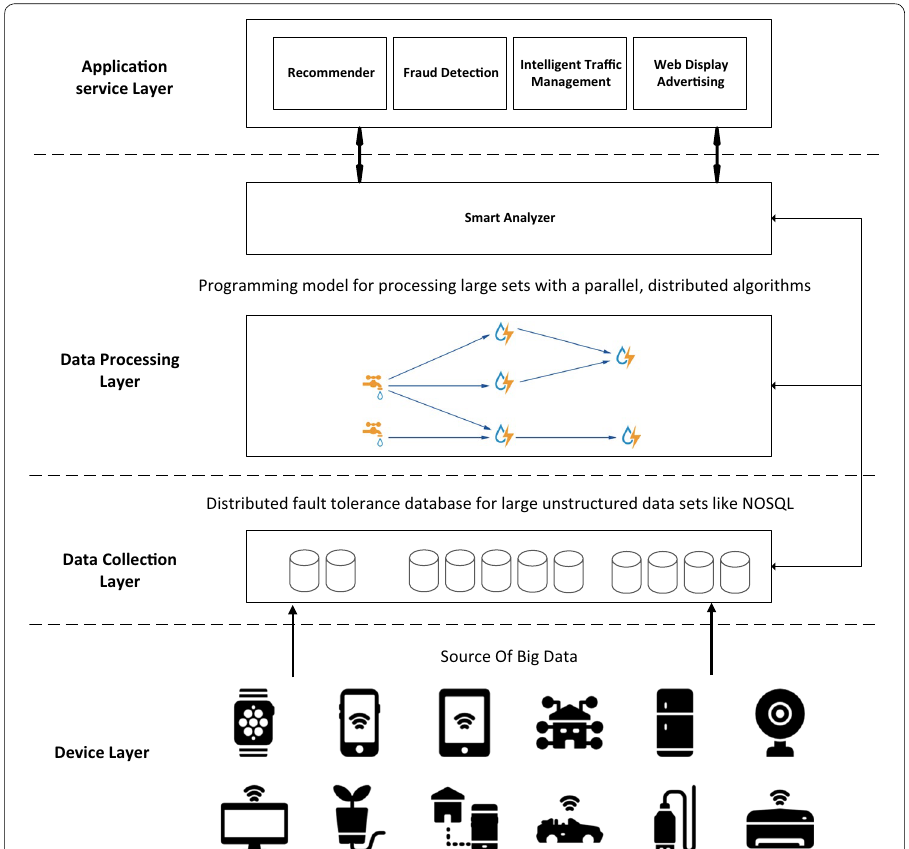
Fig. 1 System architecture of Smart